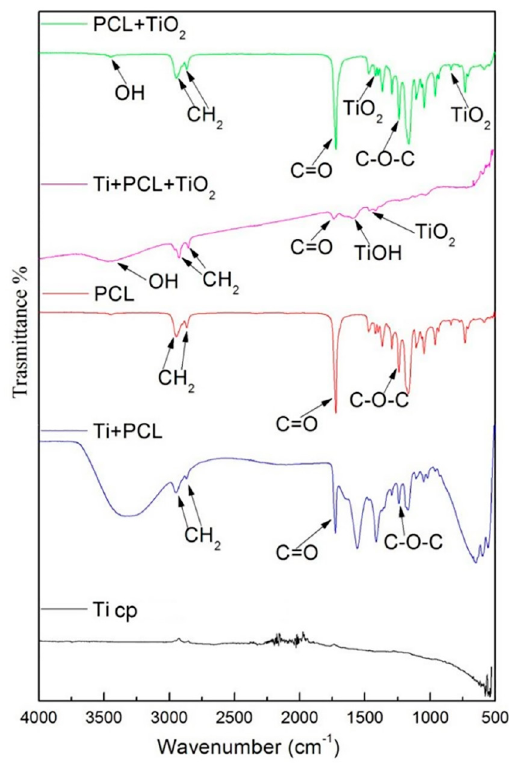
Figure 2. Infrared spectra of (black) Ti cp, (blue) Ti cp+PCL, (red) PCL film, (pink) Ticp+PCL+TiO2, and (green) PCL+TiO